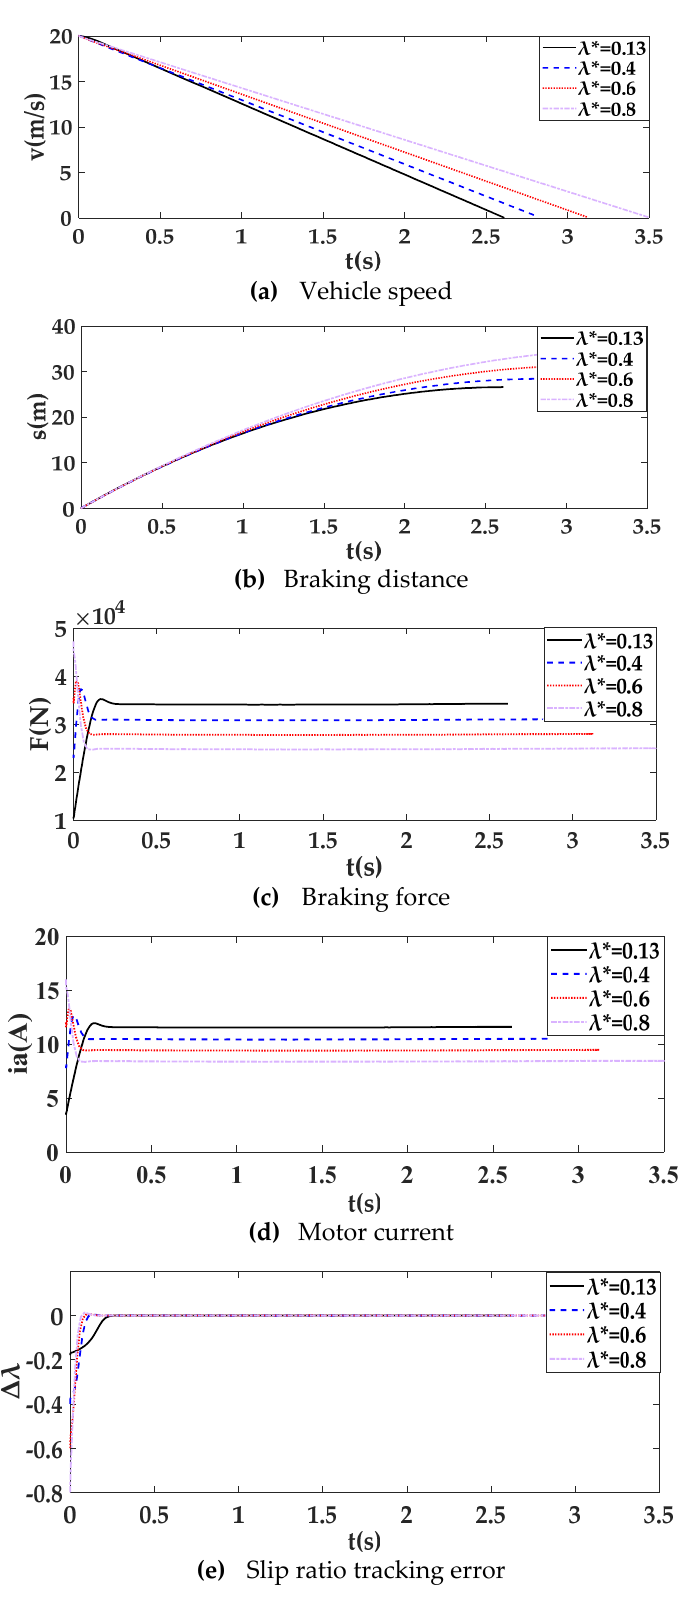
Figure 8. Wet asphalt road surface simulation.